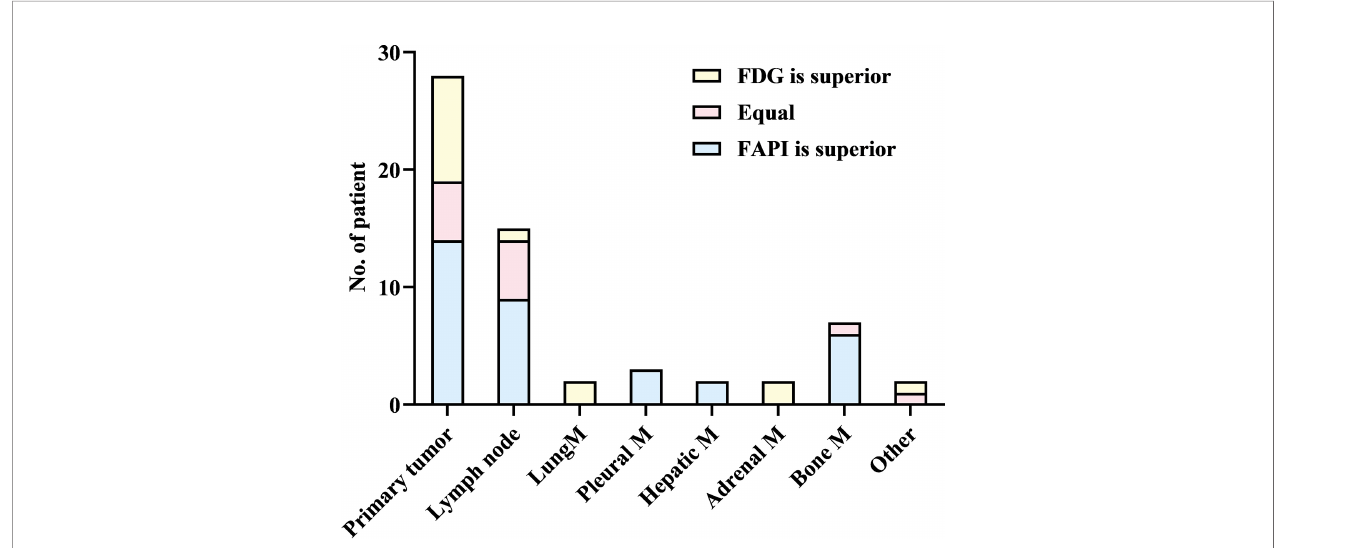
FIGURE 3 | Visual assessment comparison for 68 Ga-FAPI and 18 F-FDG PET/CT. M =